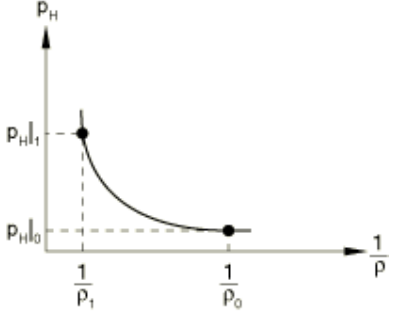
Figure 4. A schematic representation of a Hugoniot